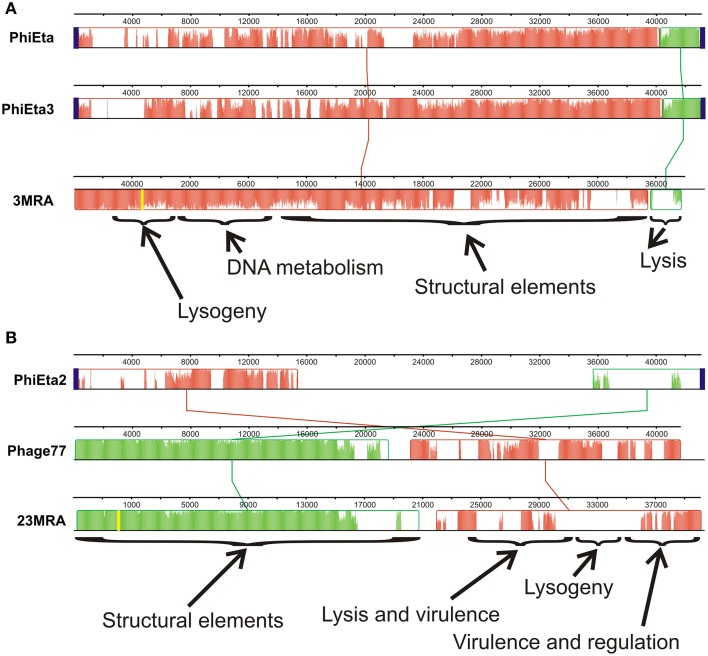
Alignments of phage 3MRA (A) and phage 23MRA (B) with various other known staphylococcal phage. The boxes represent segments of each phage that are relatively well conserved amongst the aligned phage and the lines between the boxes represent the relative position of conserved segments of each phage in the different genomes. Diagonal lines represent potential genome rearrangements. Relative locations in the genomes of each phage are demonstrated by the nucleotide numbers above each phage. The yellow lines represent the sites of the first nucleotide in the assembled 3MRA and 23MRA phage contigs. Some phage segments shown by the arrows contain conserved genes representing structural elements, DNA metabolism, lysis, lysogeny, virulence, and regulation. The height of the colors across each box represents the average conservation in that phage segment across the phage examined. attP sites, which represent the sites on phage genomes where they integrate into their host genomes, are represented by blue boxes. attP sequences were not determined for phage 3MRA and 23MRA.